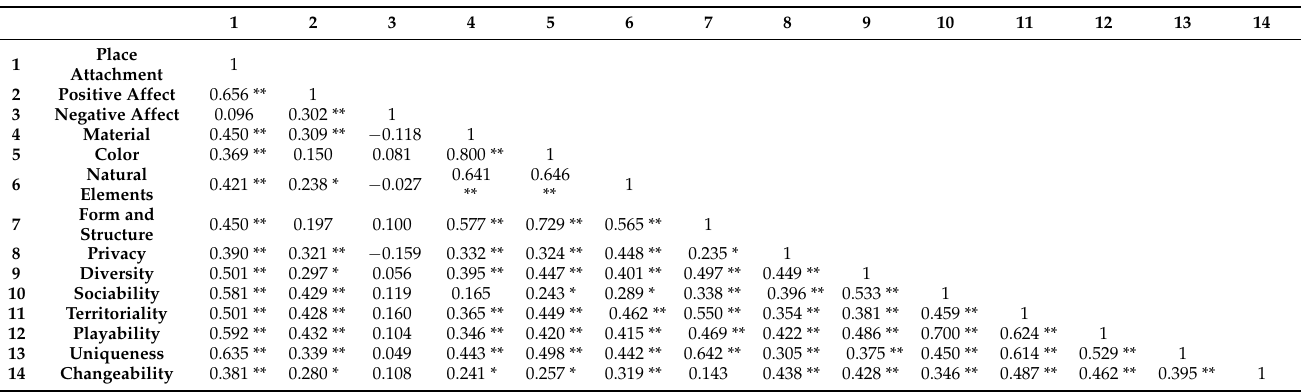
Table 7. Correlation coefficients between different attachment indicators of Taikoo